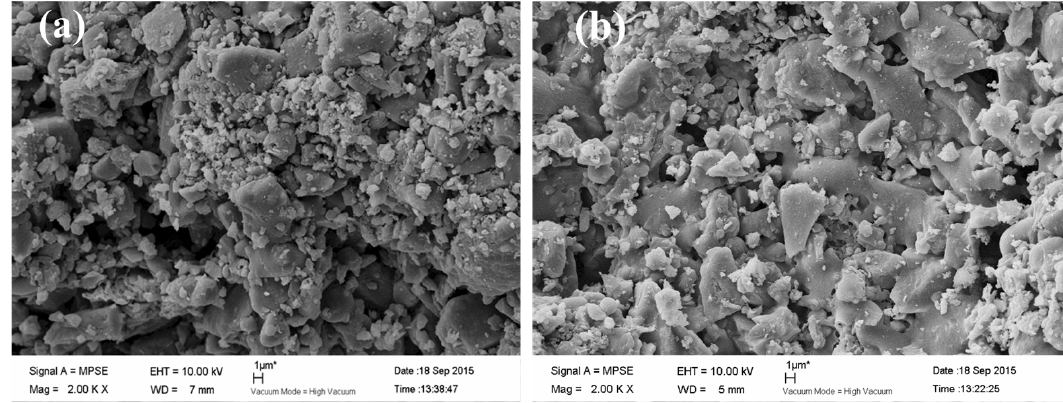
Figure 1. SEM images of the original carbon membrane ( a ) and nano-TiO 2 /carbon membrane ( b ).